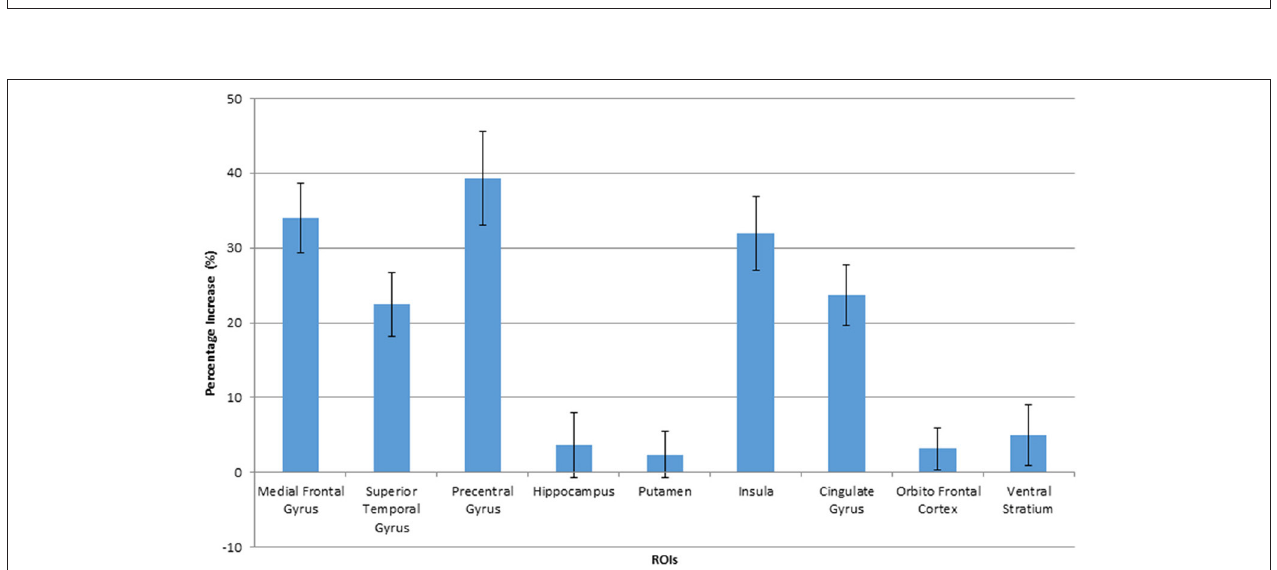
FIGURE 4 | Percentage increase in BOLD signals when viewing HF/HCCHO images, compared to vegetables, in activated ROIs. Values are expressed as a percentage of the BOLD signal response to vegetable images. The error bars show the standard deviation.